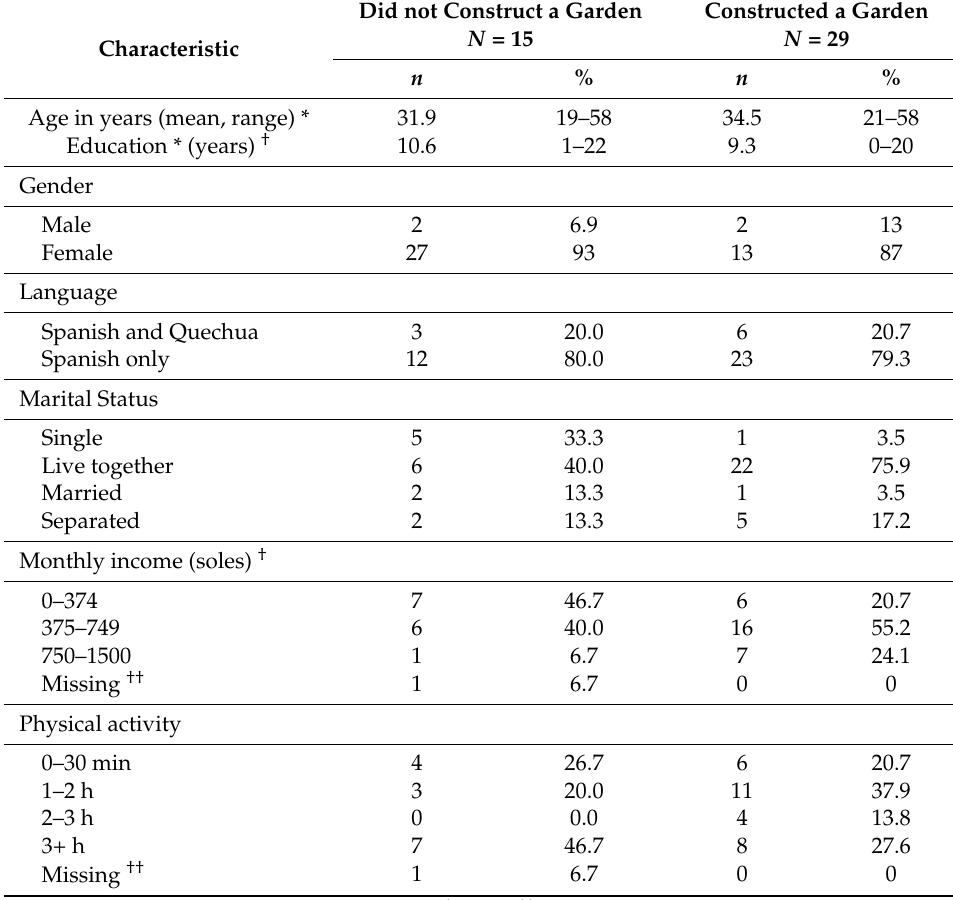
Table 1. The baseline demographics of study participants.